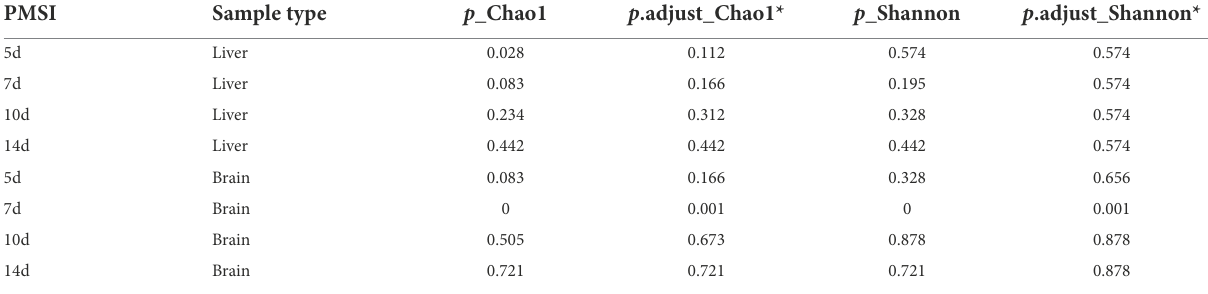
TABLE 1 Comparisons of alpha diversity indexes (Chao1 and Shannon) between drowning and postmortem submersion by Wilcoxon rank-sum test.